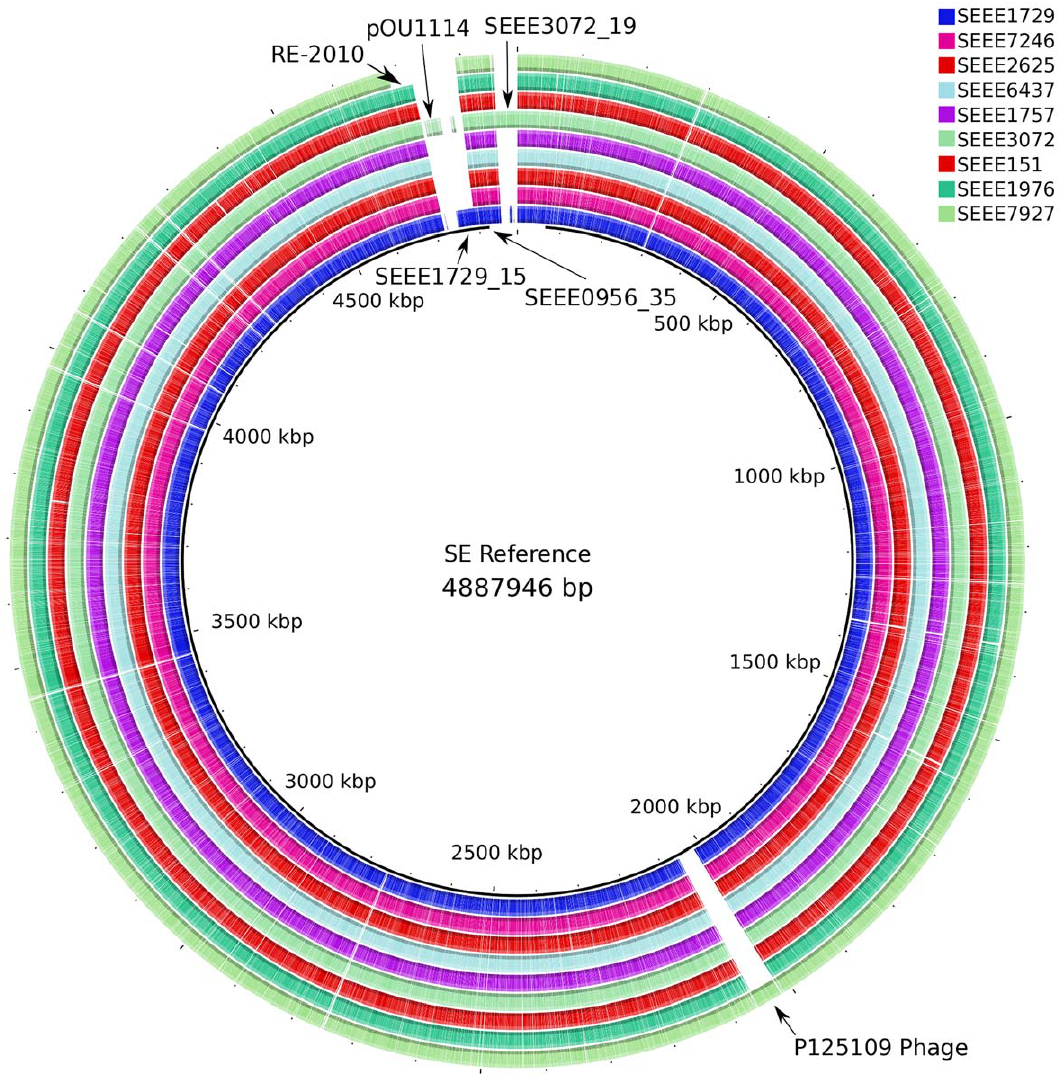
Figure 2. Circle plot showing general conservation of synteny among PFGE pattern JEGX01.0004 of Salmonella Enteritidis, with phage and plasmid differences listed for 9 representative isolates.